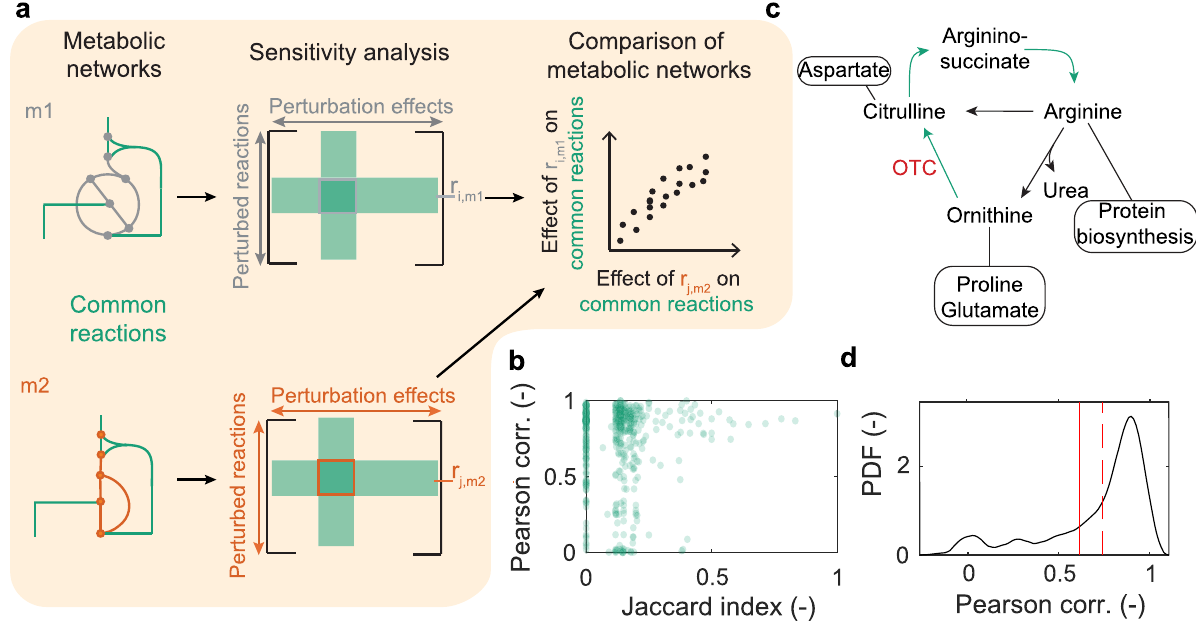
Fig. 1 | Functional comparison of metabolic networks. a Example of two meta- bolic networks with metabolites (nodes) and distinct (grey, orange edges) or common (green edges) reactions. Sensitivities quantify perturbation effects on common reactions. Correlations between each common reaction ’ s effect on net- work fl uxes yield similarity measures (see Methods). b Comparison of sensitivity correlations(Pearson)andJaccardindicescomputedonsetsofreactionsbelonging to the 1-neighborhood for E. coli and B. subtilis models; data points: individual